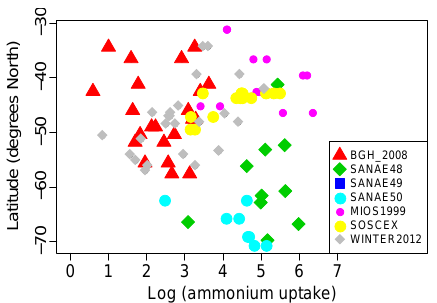
Figure 6. Comparison of nitrate uptake rates from the summer Figure 5. Comparison of ammonium uptake rates from the summer cruise (SOSCEx) and the winter cruise (WINTER2012) and previ- cruise (SOSCEx) and the winter cruise (WINTER2012) and previ- (in nmolL − 1 d − 1 ) is shown here for clarity. ous cruises. Log p NO ous cruises. Log p NH (in nmolL − 1 d − 1 ) is shown here for clarity. 4 3 The data include both the 55% and 1% light depths where avail- The data include both the 55 and 1% light depths where available able for each cruise. The summer uptake rates (SOSCEx) were con- for each cruise. The summer uptake rates (SOSCEx) were converted verted to daily rates by multiplying the average hourly rate by the to daily rates by multiplying the average hourly rate by the light pe- light period. The data shown here include data from Joubert et al. riod + half of the dark period. The data shown here include data (2011) (BGH2008), the SANAE cruises in 2009, 2010 and 2011 from Joubert et al. (2011) (BGH2008), the SANAE cruises in 2009, (SANAE48,49,50) and Thomalla et al. (2011b) (MIOS1999). The 2010 and 2011 (SANAE48,49,50) and Thomalla et al. (2011b) data and cruise reports for the SANAE cruises are available from (MIOS1999). The data and cruise reports for the SANAE cruises are the Greenseas database available from the Greenseas database (http://greenport.nersc.no).